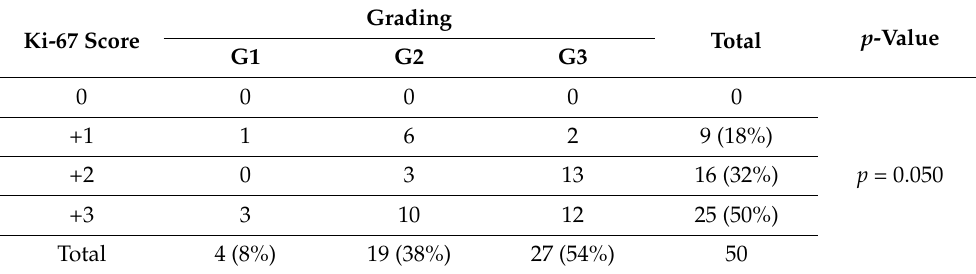
Table 4. Ki-67 index in correlation with Broder histological